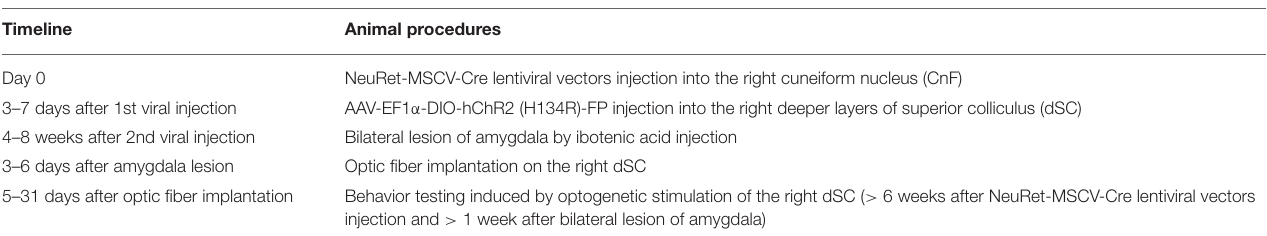
TABLE 1 | Timeline for experimental protocols.